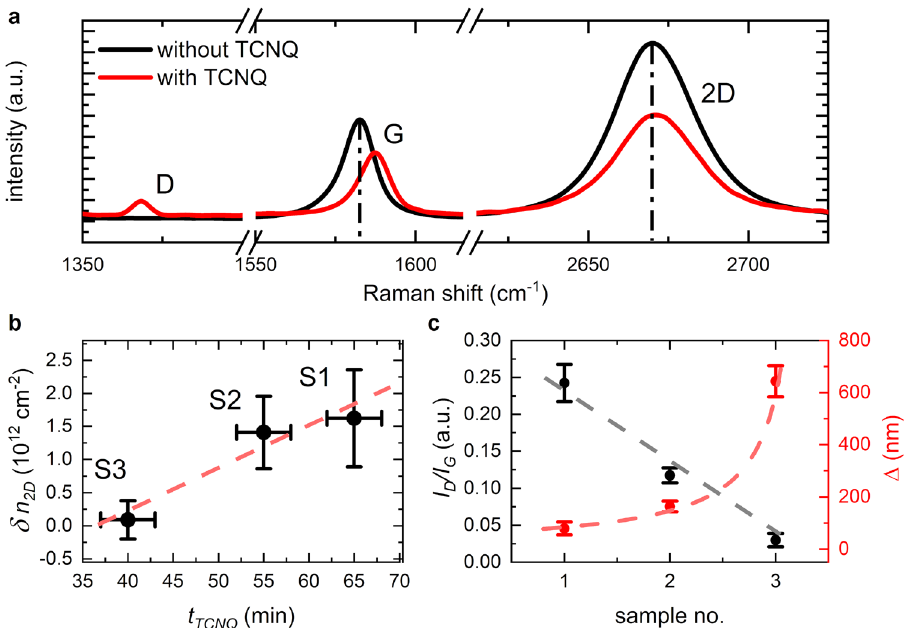
Figure 2. Micro-Raman characterization of graphene/TCNQ samples: ( a ) Exemplary Raman spectrum of a graphene sample, before and after TCNQ deposition. Displayed spectra are averages of experimental Raman maps (> 20 individual spectra). With TCNQ a clear increase in D-band intensity is observed. The shift of 1 1 ) towards higher wavenumbers indicates the electron transfer to the TCNQ 51 . 4 cm 1 cm G-band ( − − + ± Regarding the 2D band peak position, only a small shift seems to be apparent. ( b ) Change in charge carrier density δ n 2 D estimated from the G-band shift as a function of TCNQ evaporation time t TCNQ . Error bars are resulting from uncertainties in the fit procedure and random temperature fluctuations in heating and cooling phases (cf. Method section). The red dashed line serves as a guide to the eye. ( c ) Ratio of D- and G-band intensity I D I for the three samples (left axis). The larger I D I , the smaller the average spacings within the random G G TCNQ distribution as reflected by (cid:31) (right axis) 54 . Dashed line serves as guide to the